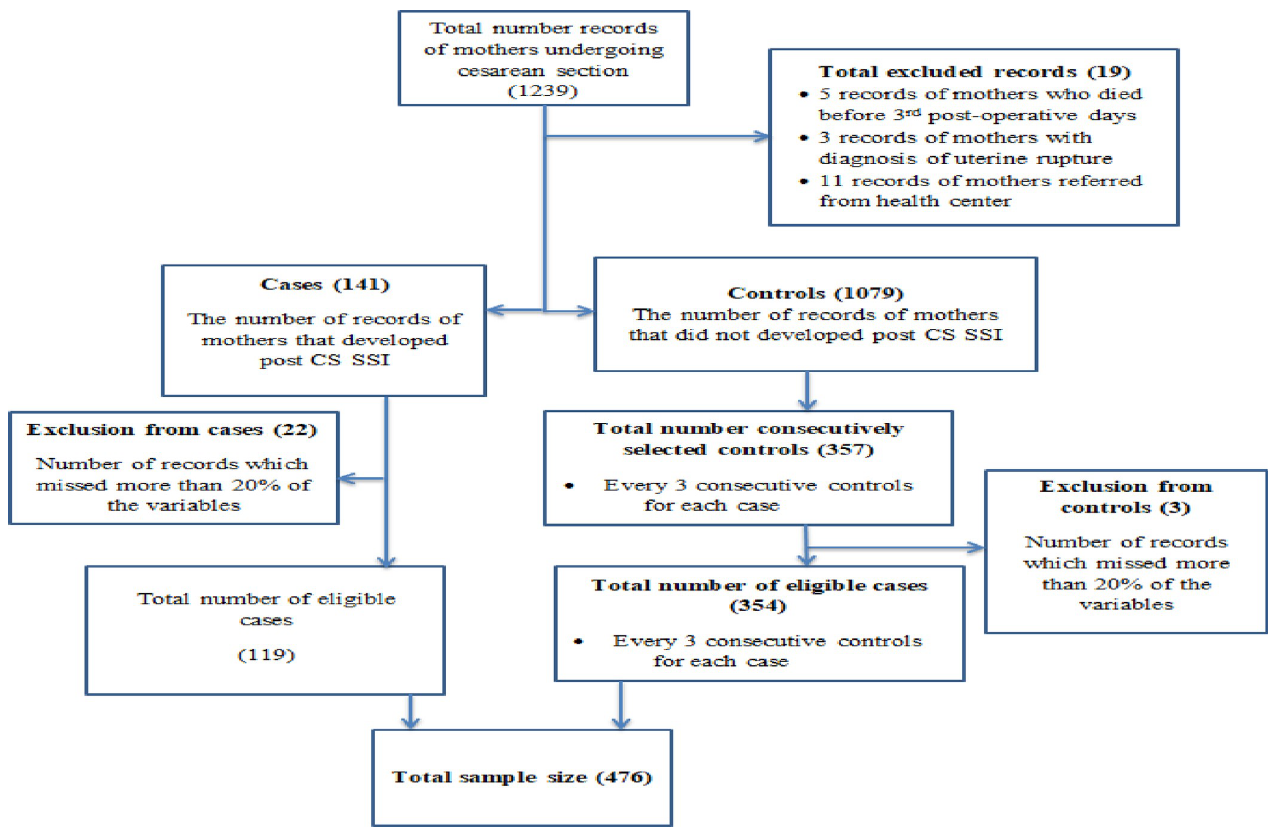
Fig 1. Schematic presentation of sampling method for the study on determinants of post cesarean section surgical site infection at public hospitals at Dire Dawa administration, Eastern Ethiopia.